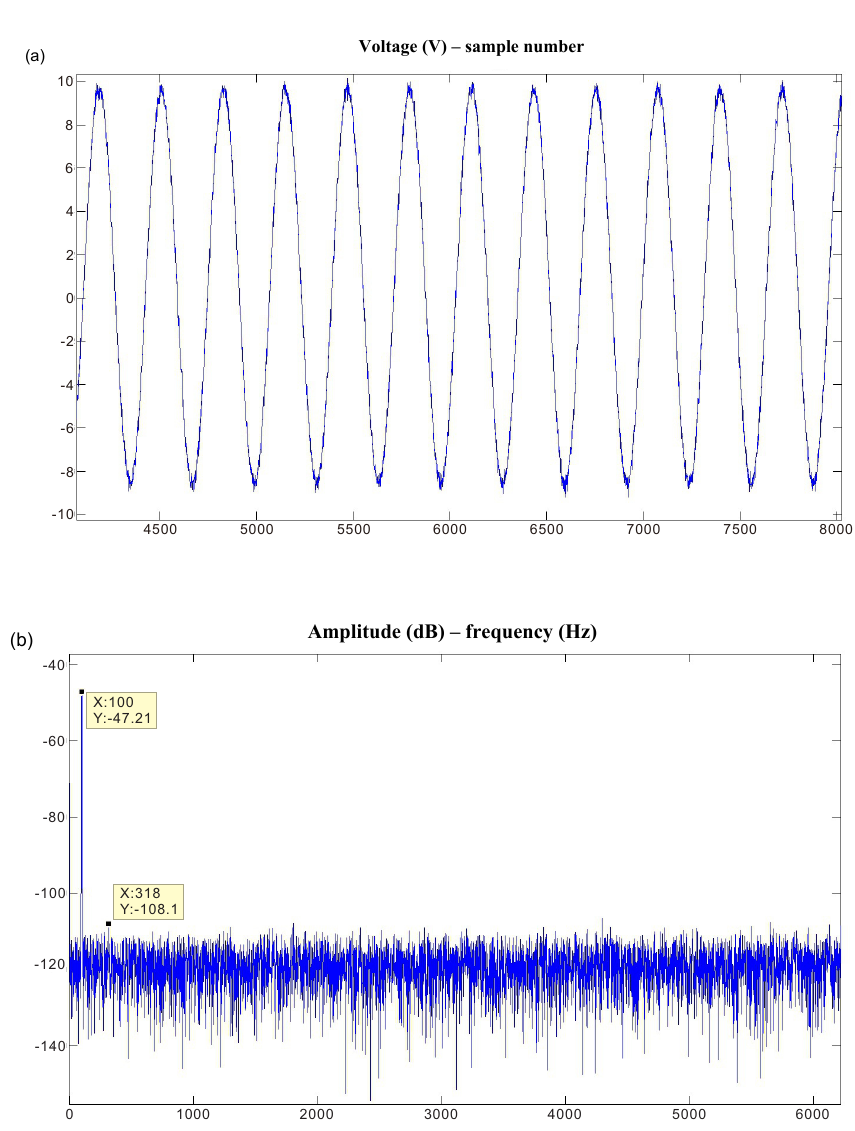
Figure 8. Test results of the low-speed voltage acquisition channel. (a) Time domain waveform of the 20Vpp, 100Hz sinusoid acquired by the recording device at a 1000V level. (b) Amplitude-frequency characteristics of the 32000 samples subjected to FFT (Hanning window